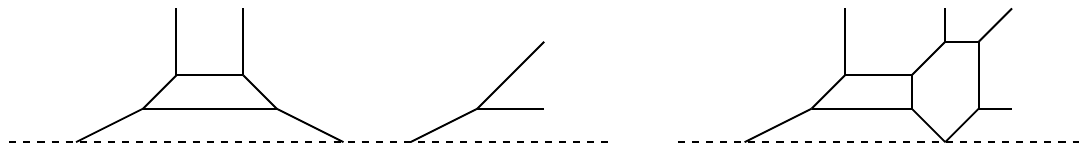
Figure 12. Left: the web diagram for SO(4) gauge theory with 1 s + 1 c . Right: the web after flop transitions.